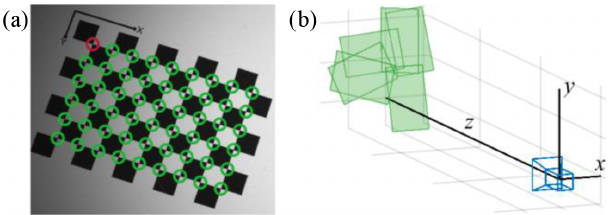
Figure 5. Camera calibration with (a) detected control points of the calibration pattern and (b) visualisation of the extrinsic parameters of some orientations of the